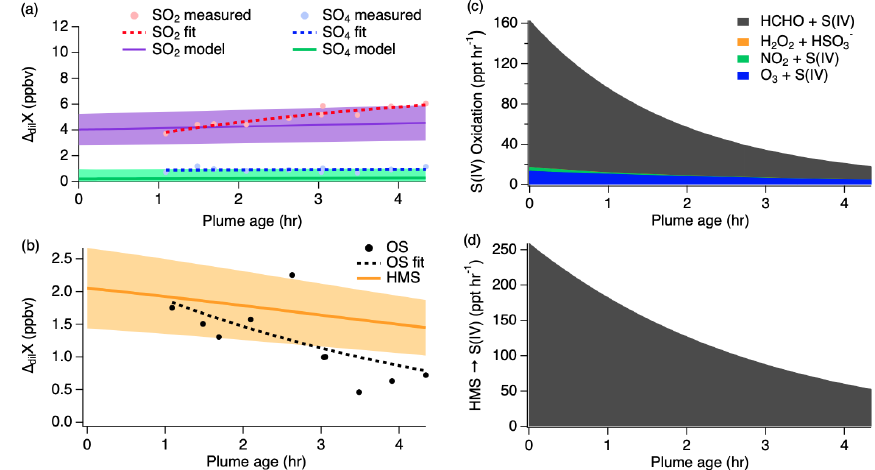
Figure 8. First pass dilution-corrected ( (cid:49) dil X) measurements shown by the markers and measurement fits shown by the dashed lines compared to the model results represented by the solid lines, with shading denoting an estimated 30% model uncertainty for SO 2 and sulfate (a) as well as OS (b) . Stacked modeled S(IV) oxidation rates (c) leading to sulfate and HMS production. HMS reverse reaction rate (d) reproducing